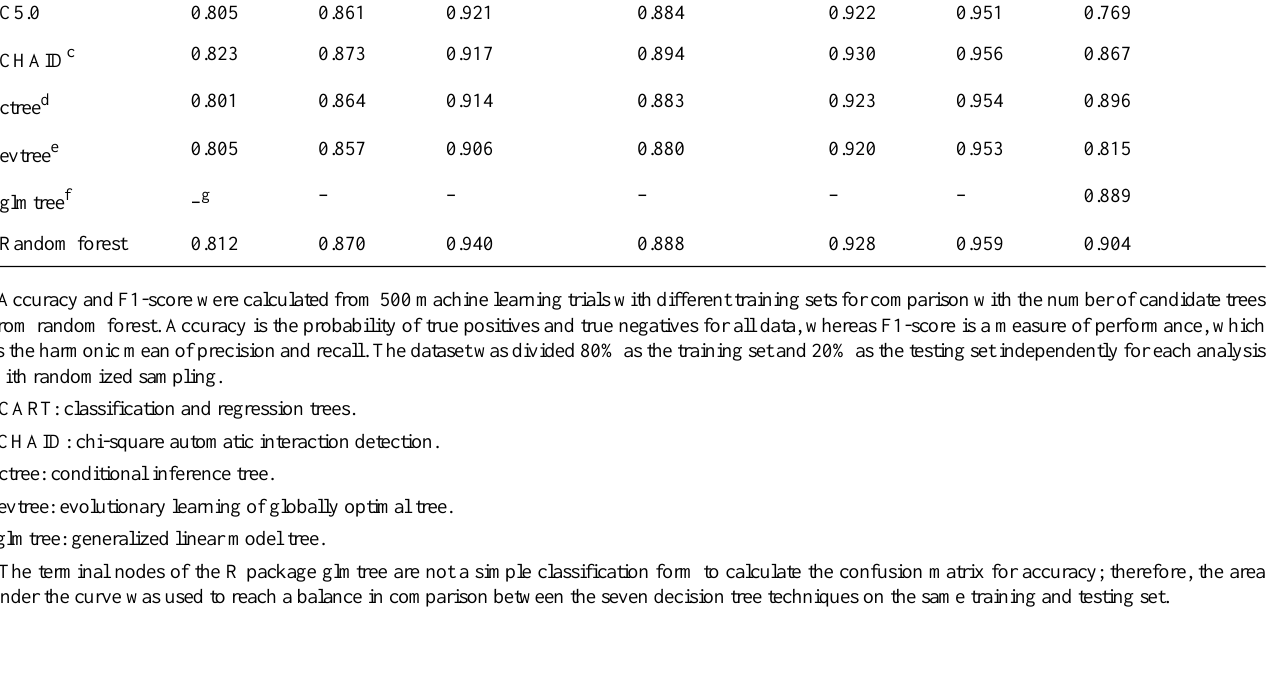
Table 4. Accuracya and area under the curve (AUC) values of various decision trees in receiver operating characteristic curve analysis. AUCF1-scoreAccuracyDecision tree